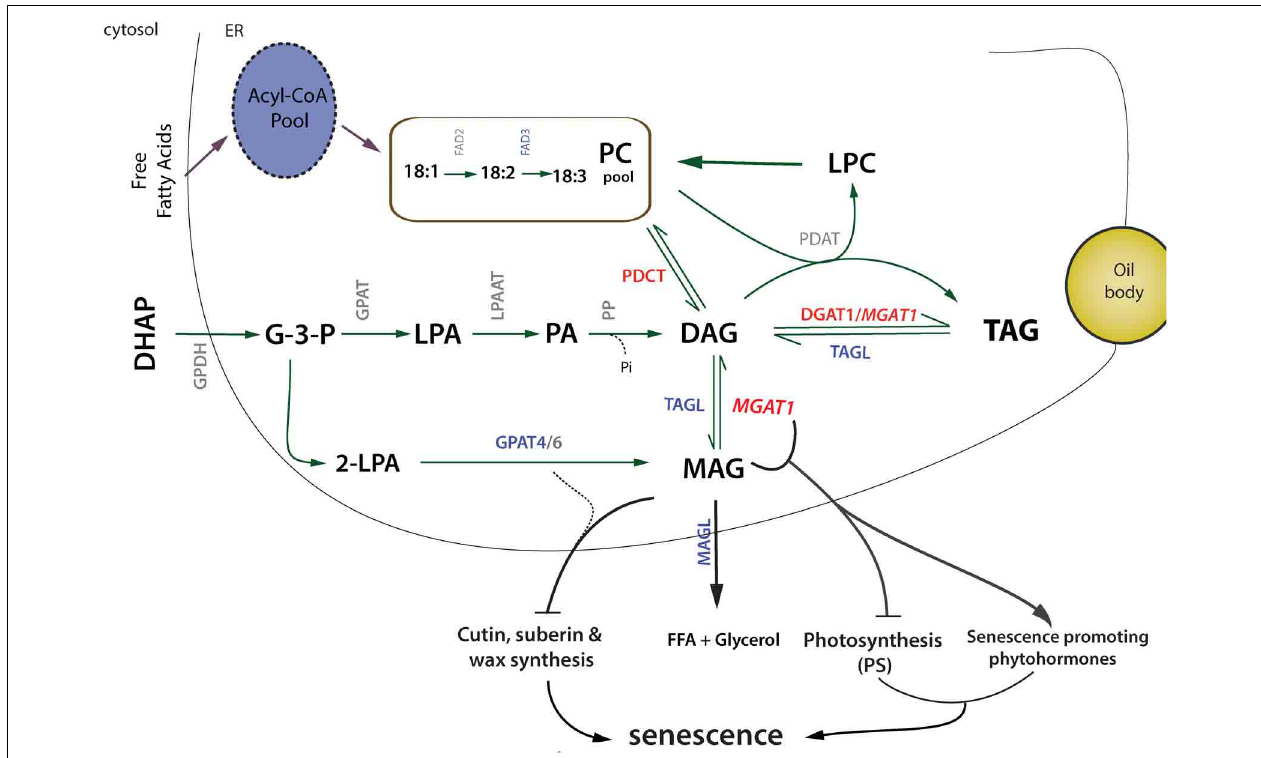
FIGURE 8 | Schematic overview of MGAT1 -induced TAG increase and senescence-like response. Up- (red) and down-regulated (bue) genes are highlighted. Transient expression of MGAT1 and subsequent up-regulation of PDCT possibly result in enhanced DAG synthesis from MAG and PC, respectively. DAG is subsequently converted to TAG due to the co-ordinated up-regulation of DGAT1 and DGAT side-activity of MGAT1 . Down-regulation of TAG and MAG lipases ( TAGL and MAGL )